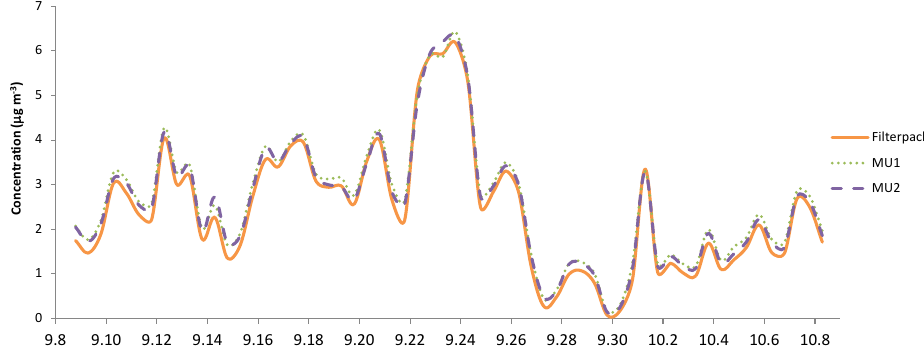
Figure 2. Filter pack and MU measured SO 2 − Fig. 2. Filter pack and MUs measured SO 42- concentrations during the ETV period. 2